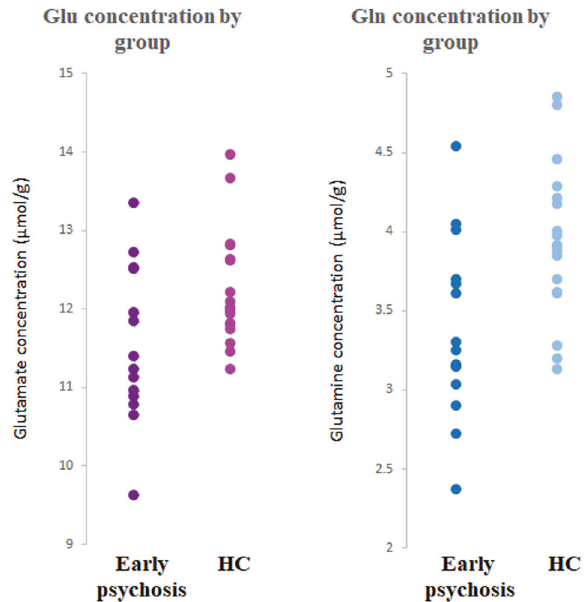
Fig. 2 Glutamate (Glu) and glutamine (Gln) concentrations in the ACC by group. In the ACC, concentrations (in μ mol/lg) of both glutamate (Glu) and glutamine (Gln) were signi fi cantly lower in patients with early psychosis (n = 14) than healthy controls (HC, n = 18) (respectively, p = 0.029 and